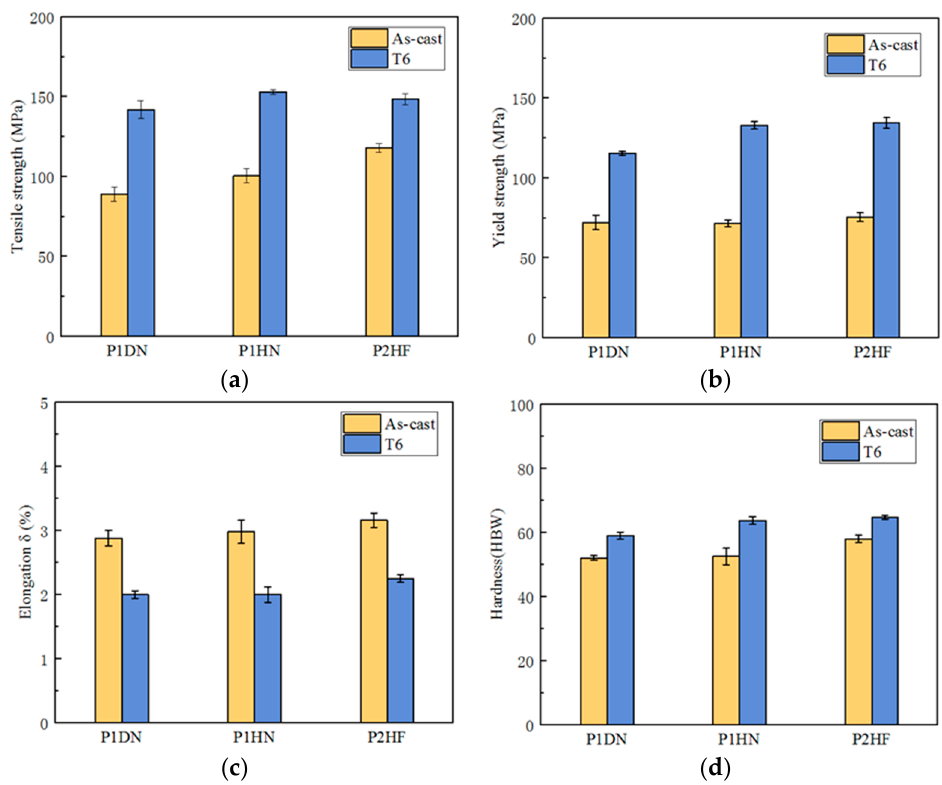
Figure 14. Mechanical properties of A356 alloys with different sand mold and heat treatments. ( a ) Tensile strength (Rm), ( b ) yield strength (Rp 0.2), ( c ) elongation (EL), and ( d ) hardness.